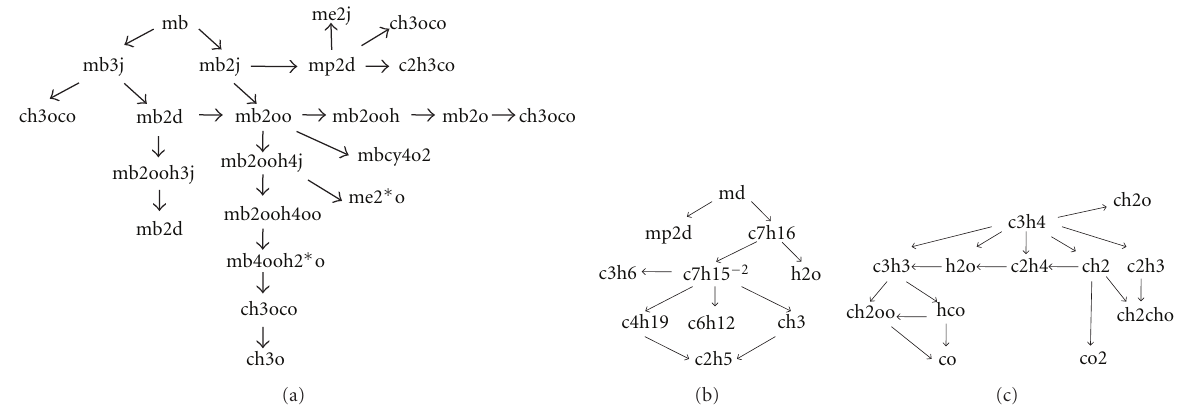
Figure 1: The oxidation pathway analysis for substituent components (a) methyl butanoate, C 5 H 10 H 2 , (b) methyl decanoate, C 11 H 22 O 2 , (c) allene, C 3 H 4 .